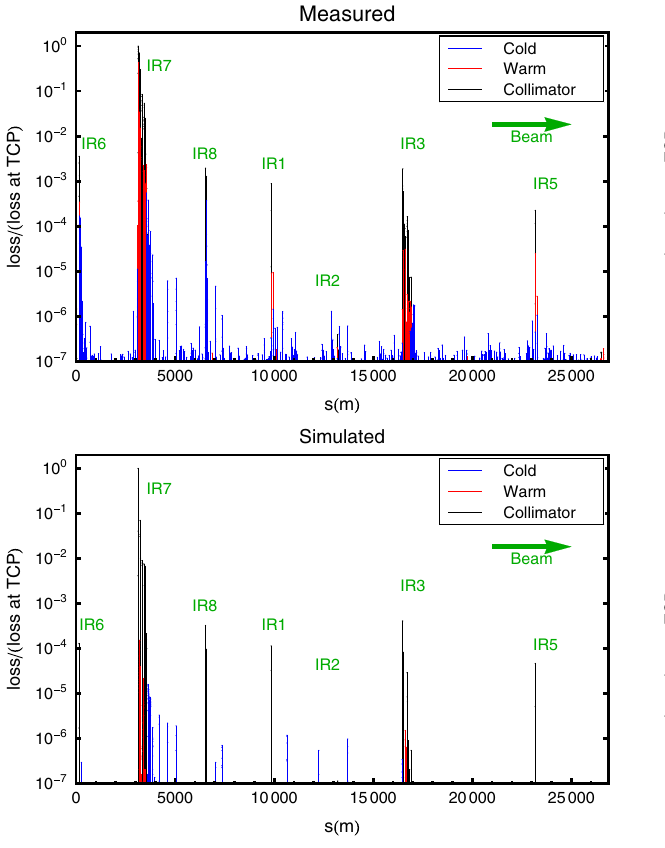
FIG. 6. Beam loss distributions around the LHC as measured by BLMs during a qualification loss map on April 12, 2011 (top) and from a SixTrack simulation (bottom), with the results binned in 1 m intervals. Both simulation and measurement assume a beam energy of 3.5 TeV and β (cid:2) ¼ 1 . 5 m. They are both normalized to the highest loss, and the initial losses occur in the horizontal plane in B1.